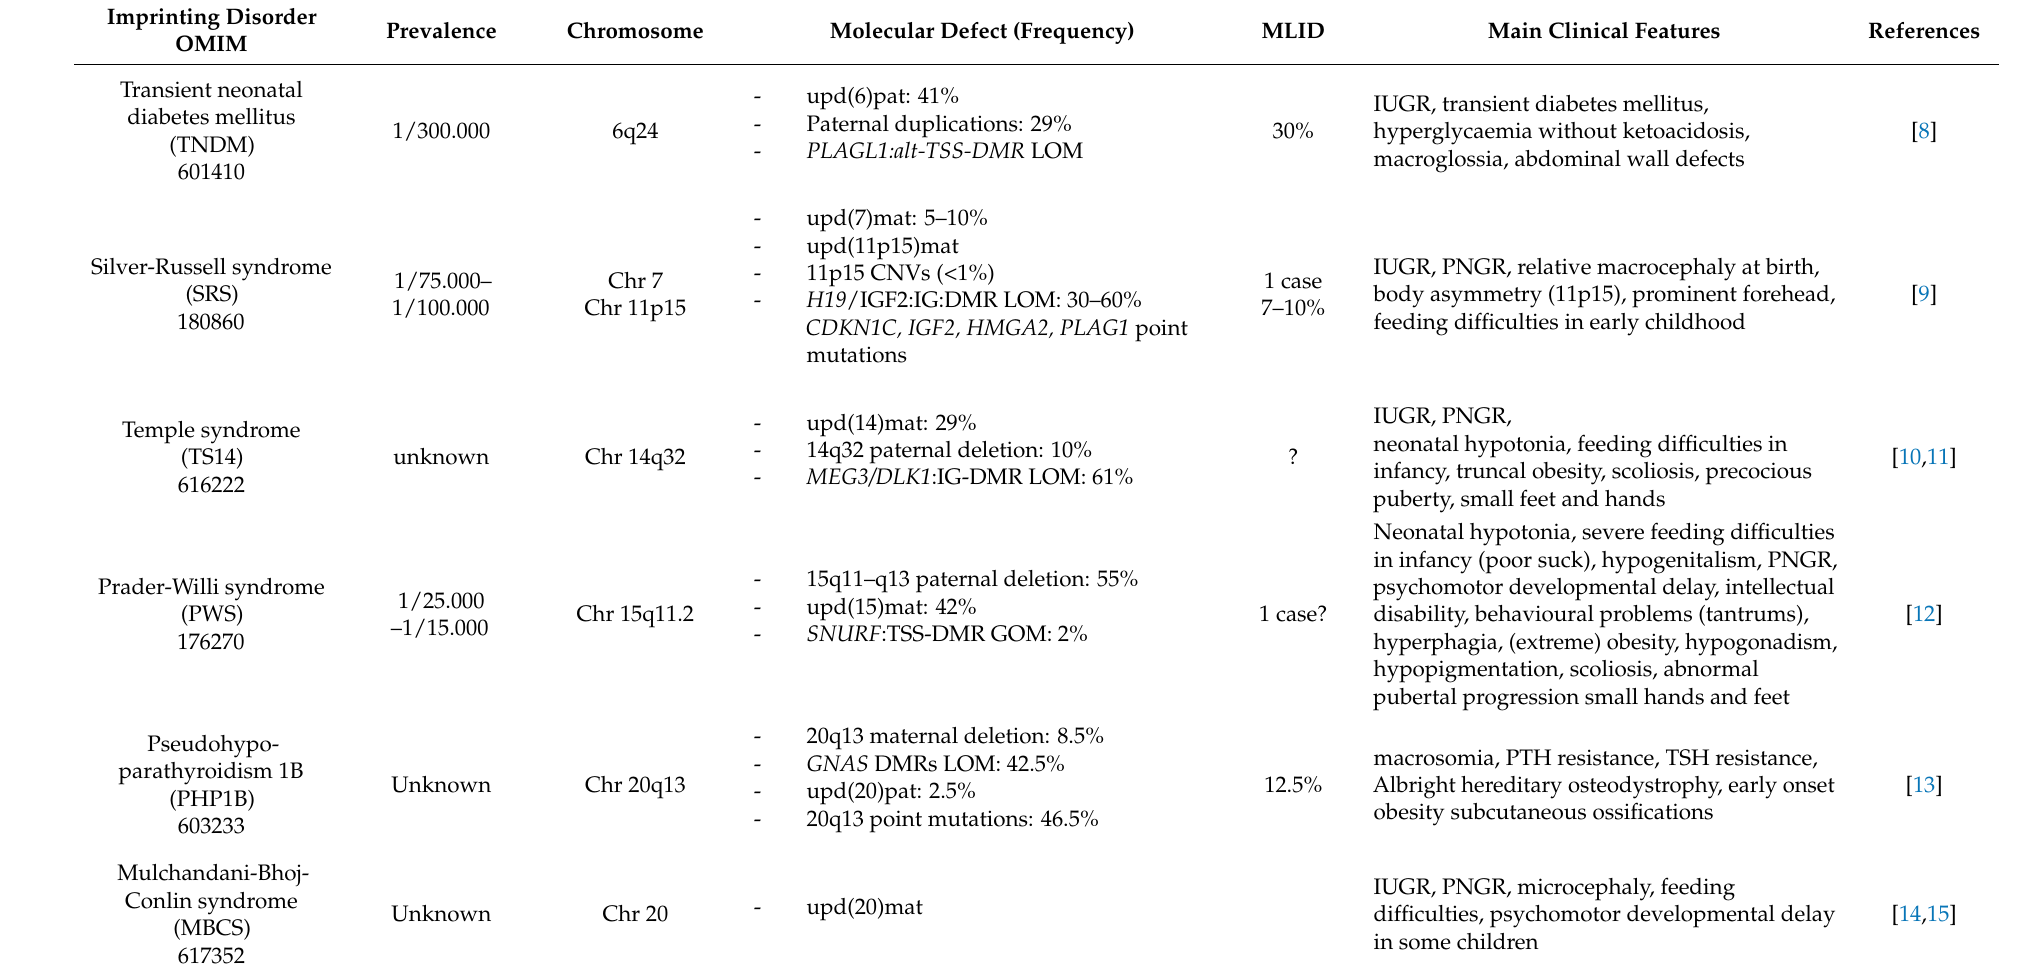
Table 1. Summary of the imprinting disorders characterised by growth disturbances, those disorders without altered growth are not listed. (GOM, gain of methylation; IUGR, intrauterine growth restriction; LOM, loss of methylation; PNGR, postnatal growth restriction; PTH, parathyroid hormone; UPD, uniparental disomy; MLID, Multilocus Imprinting Defects; for the nomenclature of DMRs see [7]); ? not yet reported or